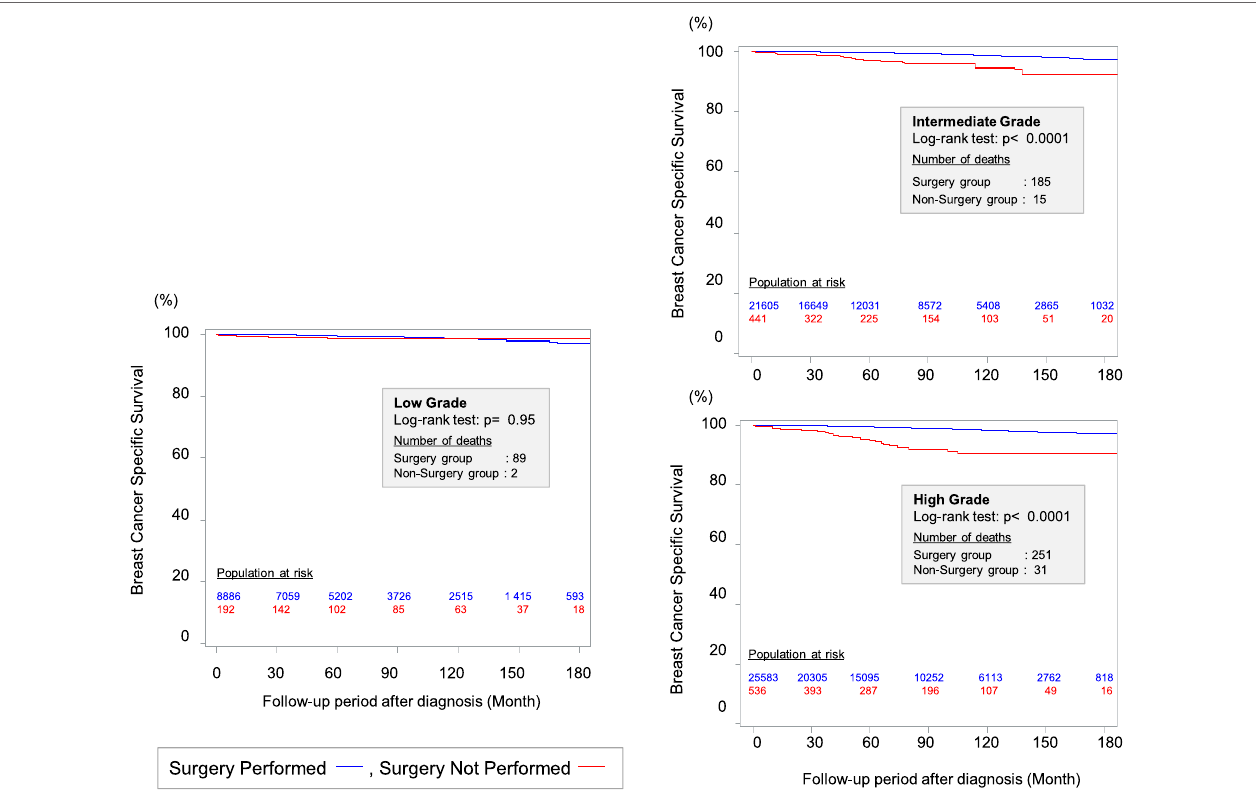
FiGURe 1 | Kaplan–Meier curves for breast cancer-specific survival between surgery group and non-surgery group among patients weighted by inverse propensity score. Sagara et al.